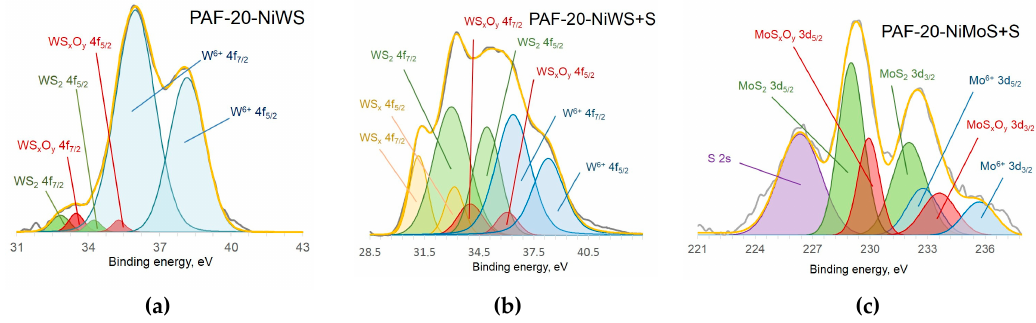
Figure 5. Deconvolution of W4 f and Mo3 d levels for catalysts after reaction: ( a ) PAF ‐ 20 ‐ NiWS; ( b ) PAF ‐ 20 ‐ NiWS, reaction in the presence of sulfur; and ( c ) PAF ‐ 20 ‐ NiMoS, reaction in the presence of sulfur.